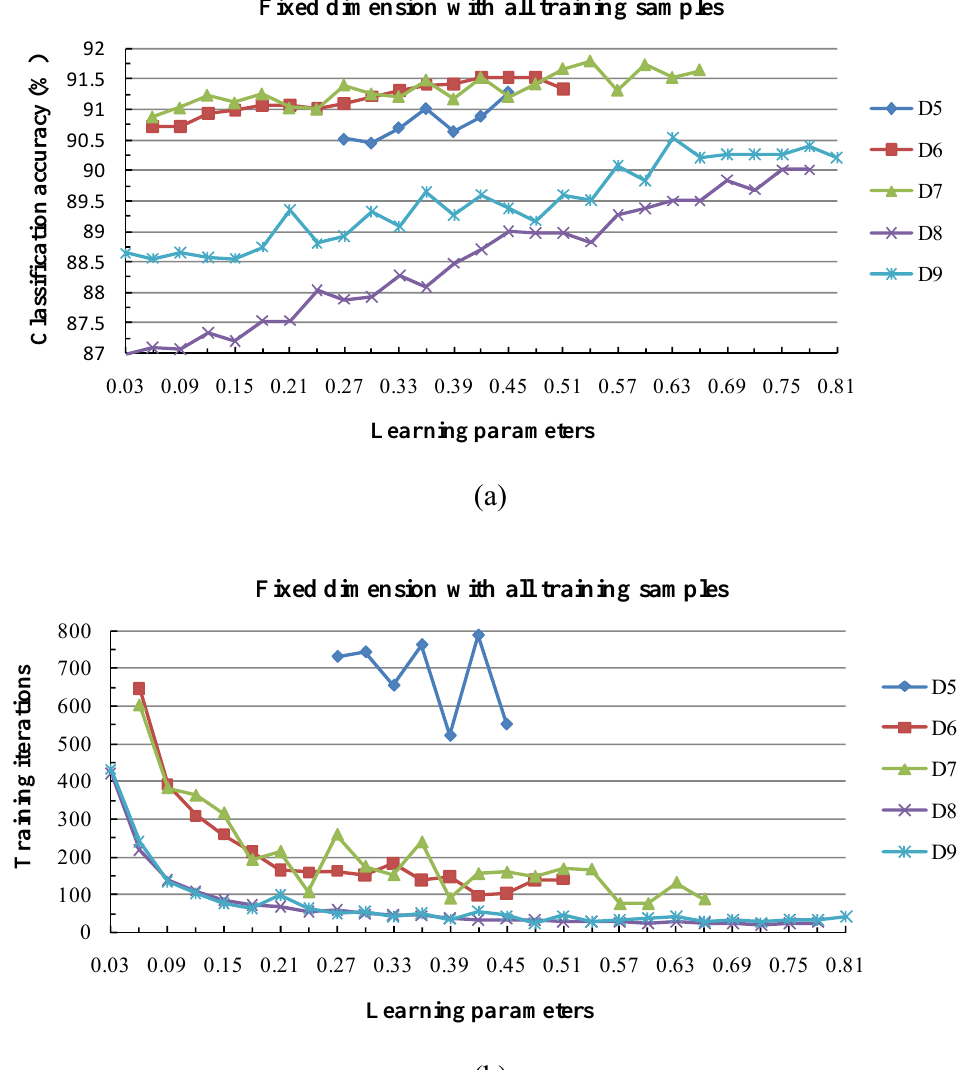
Figure 8. (a) Classification accuracy and (b) maximum training iterations for various subspace dimensions and learning parameters. The highest classification accuracy of 91.79% was reached by D7 with a learning parameter of 0.54; the corresponding maximum training iteration was 167. Fixed dimension with all training samples